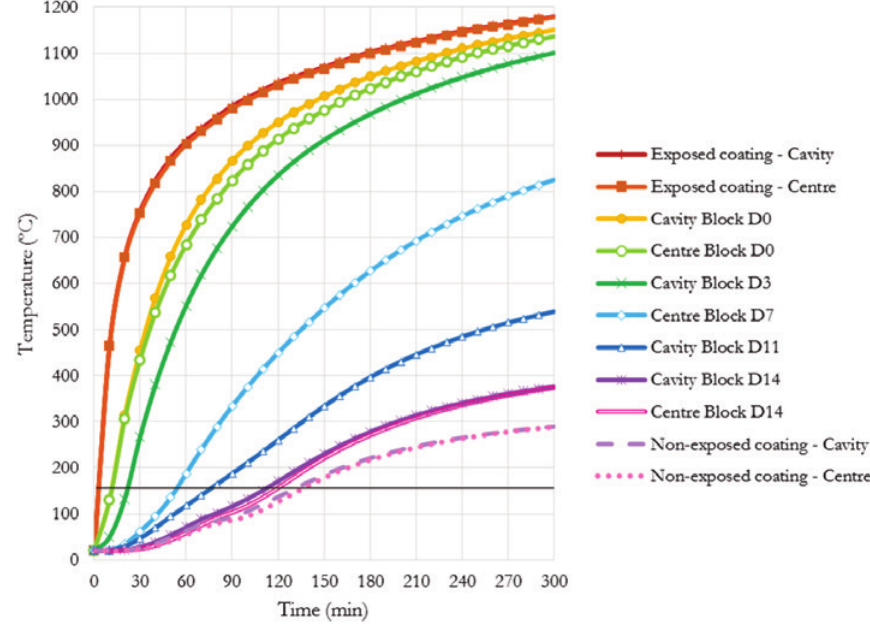
Temperature variation at various points of the coated prism on both faces